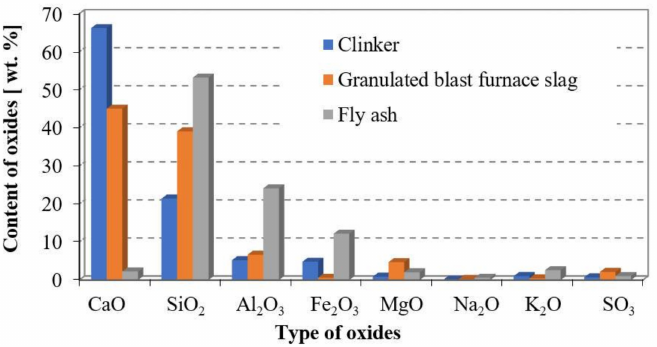
Figure 1. Chemical composition of clinker, granulated blast-furnace slag, fly